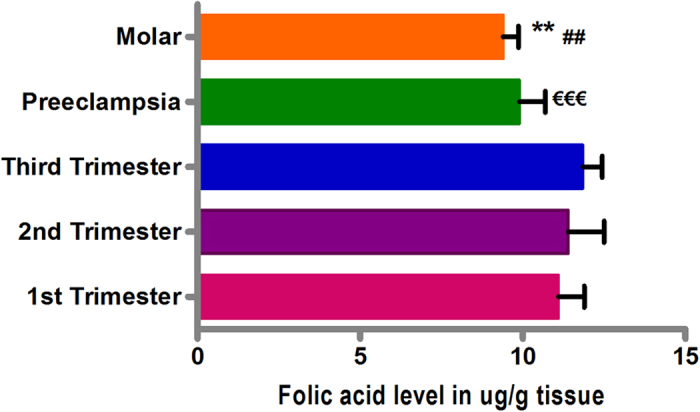
Relative Folic acid levels among different placental villi samples categories.Folate levels in ug/g of villous tissue in normal 1st, 2nd and 3rd trimester, preeclampsia and molar villi samples. The data are expressed as mean value ± SEM. **p < 0.01, ##p < 0.01 w.r.t second trimester and €€€p < 0.001 w.r.t third trimester.